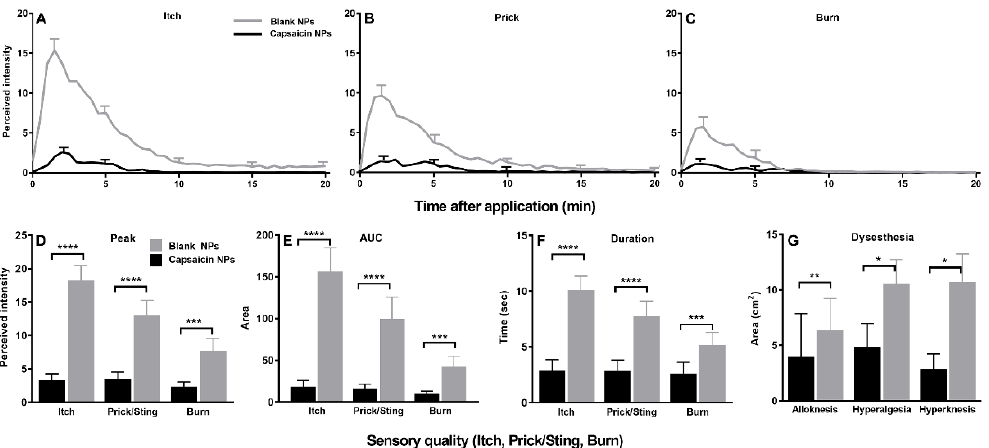
Figure 6. Effects of capsaicin NPs pretreatment on cowhage evoked sensations and dysesthesias applied by spicules. ( A – C ) Time course of perceived intensities of itch, pricking/stinging, and burning. Data are means with SEMs. For clarity, the SEMs are presented at the peak and every 5 min thereafter. ( D ) Peak magnitude (Peak) of each sensory quality. ( E ) Area under the rating curve (AUC). ( F ) Duration of response. ( G ) Area of each type of dysesthesia: alloknesis, hyperalgesia and hyperknesis. n = 21, ( A – C ) repeated measures two-way ANOVA; two repeated treatment groups (capsaicin vs. placebo treatment) × 40 repeated timepoints (0–20 min) with Bonferroni correction,